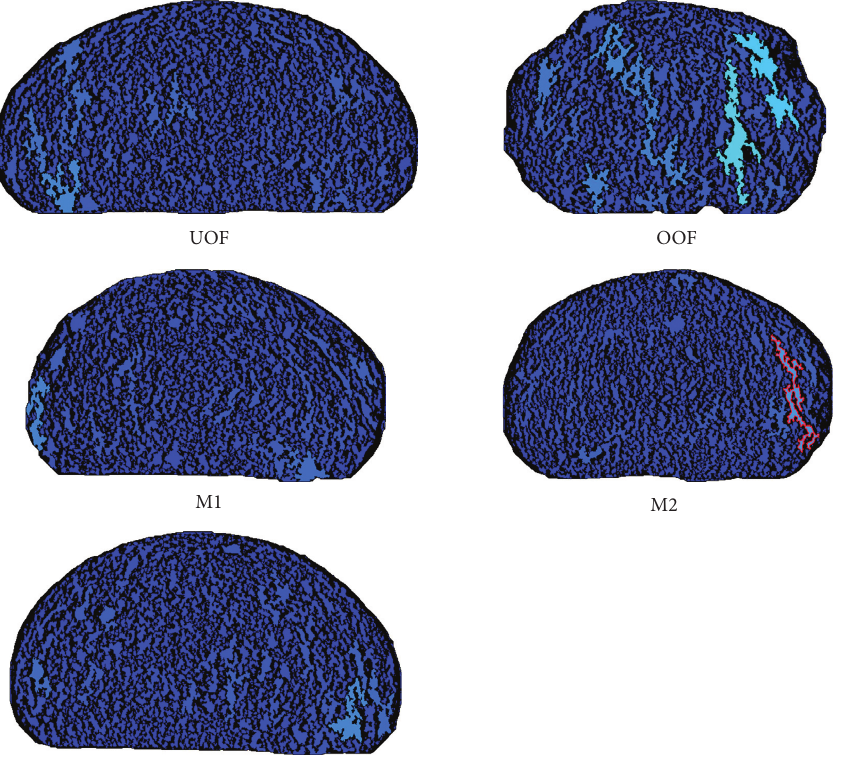
Figure 6: C-Cell images of steamed bread made from wheat flour added with different ratios of overozonized wheat